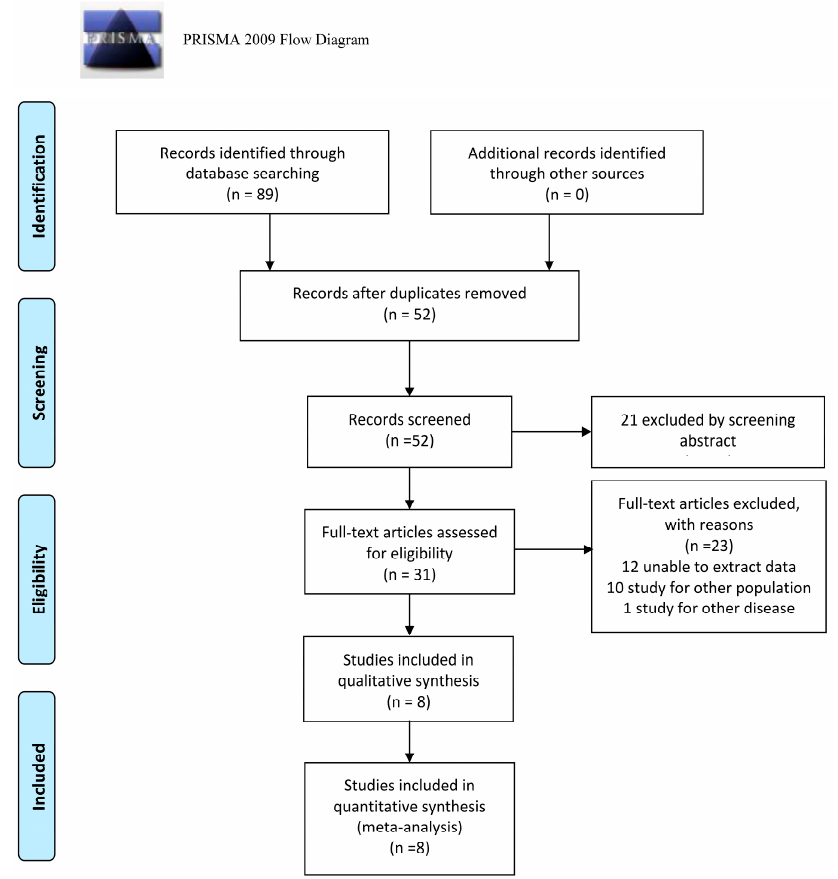
Figure 1. Flow chart of study identification and inclusion.